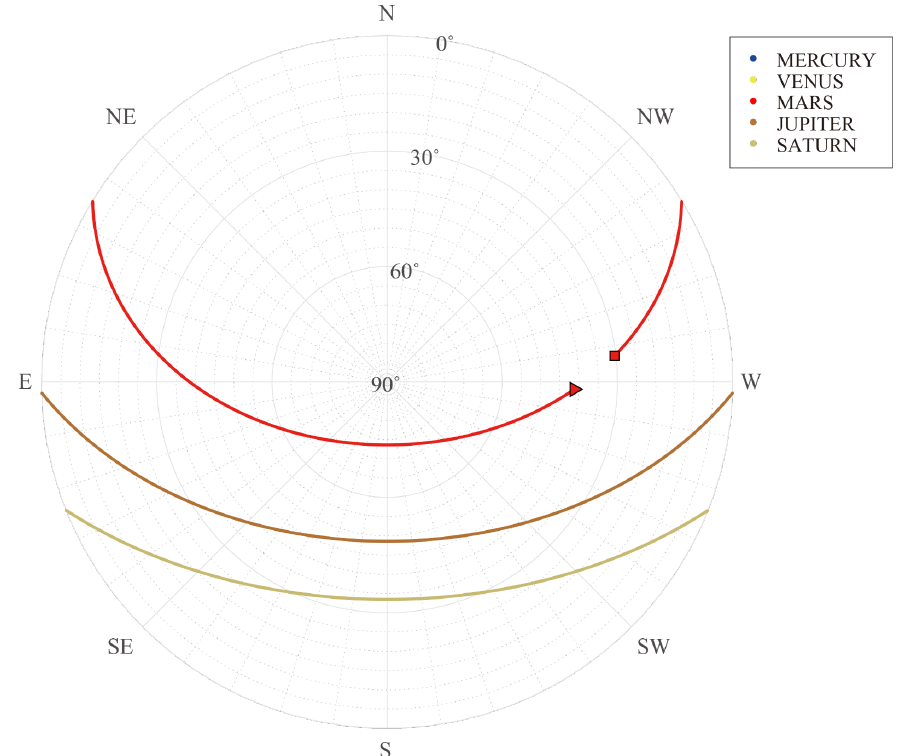
Figure 10. Observable altitude and azimuth positions of targets in the local PAST coordinate system at corresponding OBW on 26 October 2022. If the target will be observable at the beginning time and ending time of the day, the corresponding positions at these times are denoted by squares and triangles, respectively. Remote Sens. 2021 , 13 , x FOR PEER REVIEW